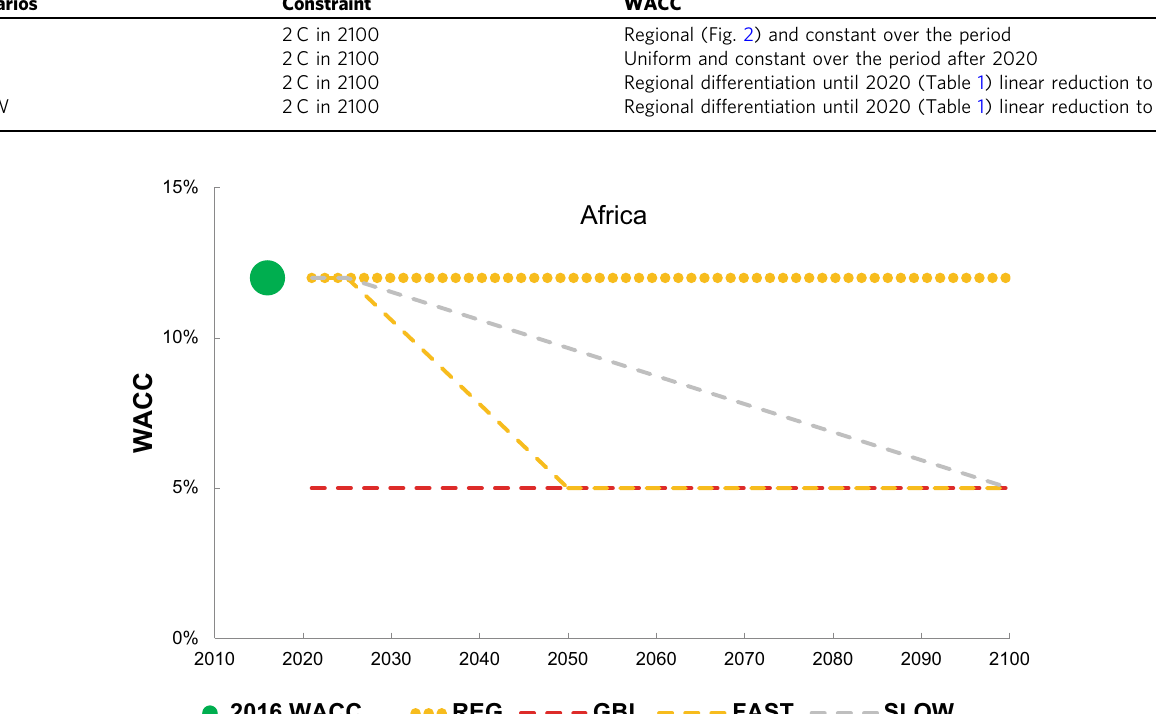
Table 3 Scenarios implemented in the TIAM-UCL model. Scenarios